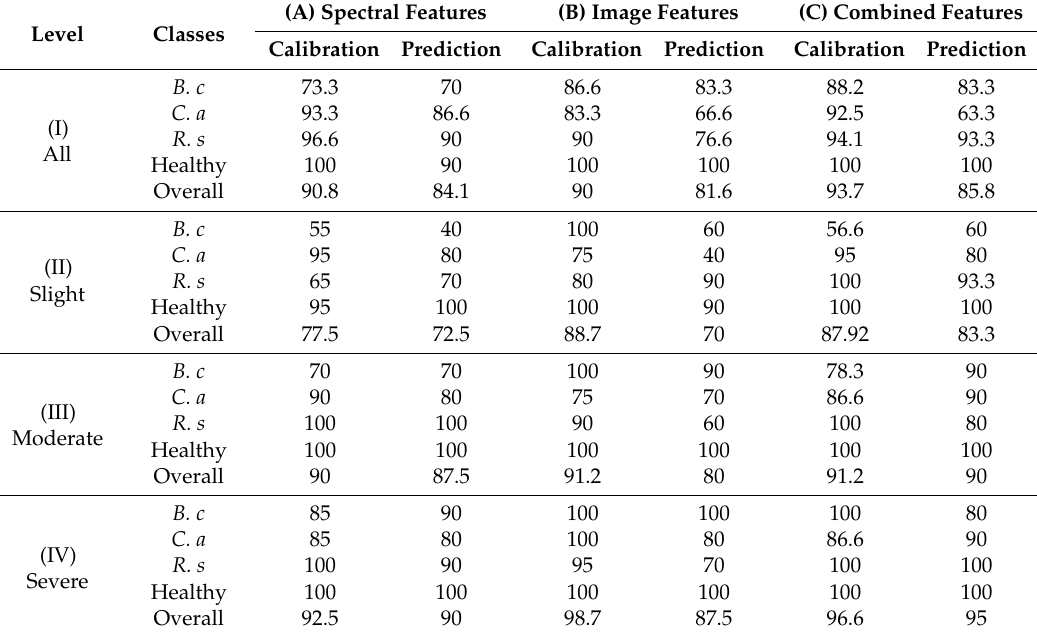
Table 2. The results of the classification of three fungal diseases in peaches for three levels of decay, using the spectral and image features of DBN